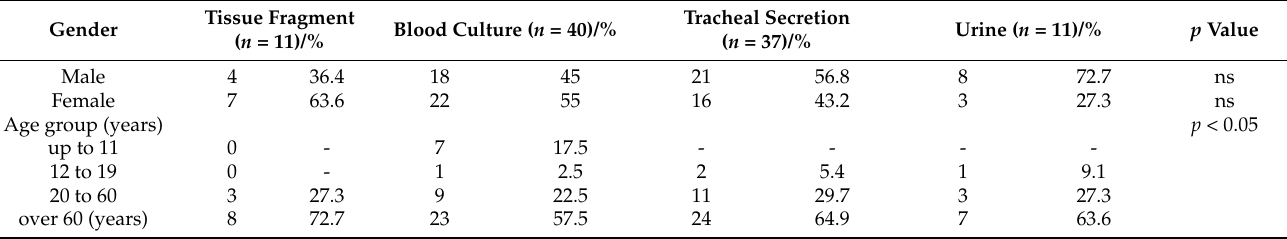
Table 3. Distribution of Pseudomonas aeruginosa isolates according to gender, age group, and number of isolates from the type of clinical specimen.